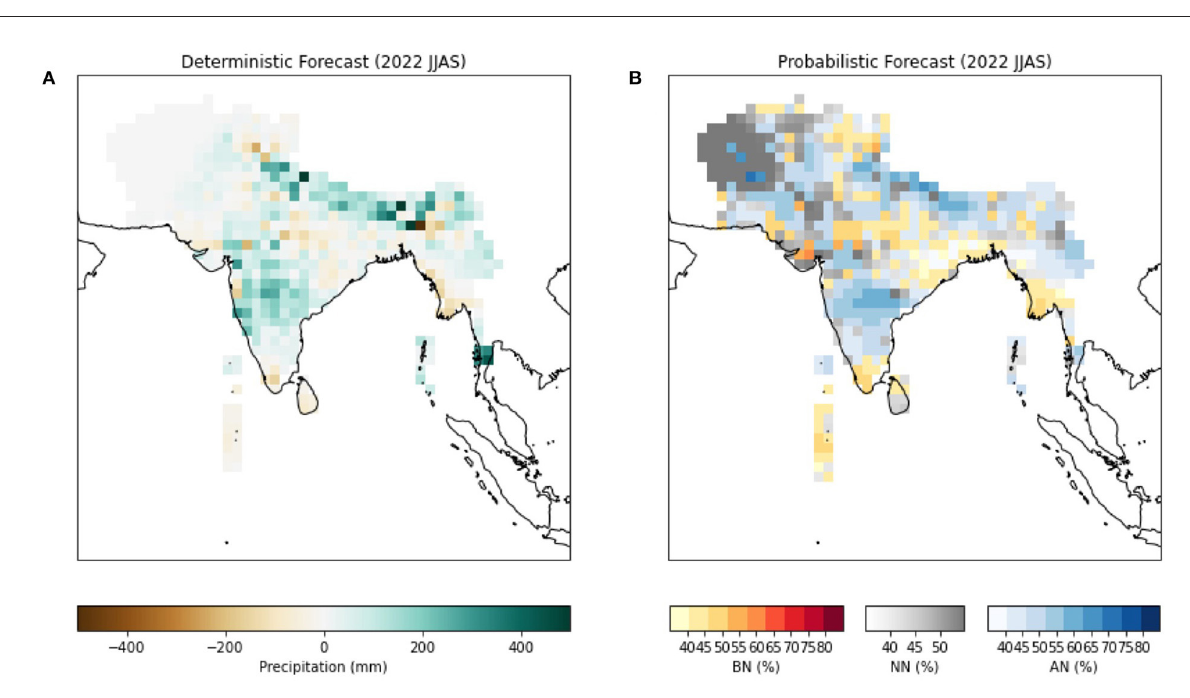
FIGURE9 Deterministic (A) and probabilistic (B) forecasts of 2022 South Asian Summer Monsoon Rainfall produced with